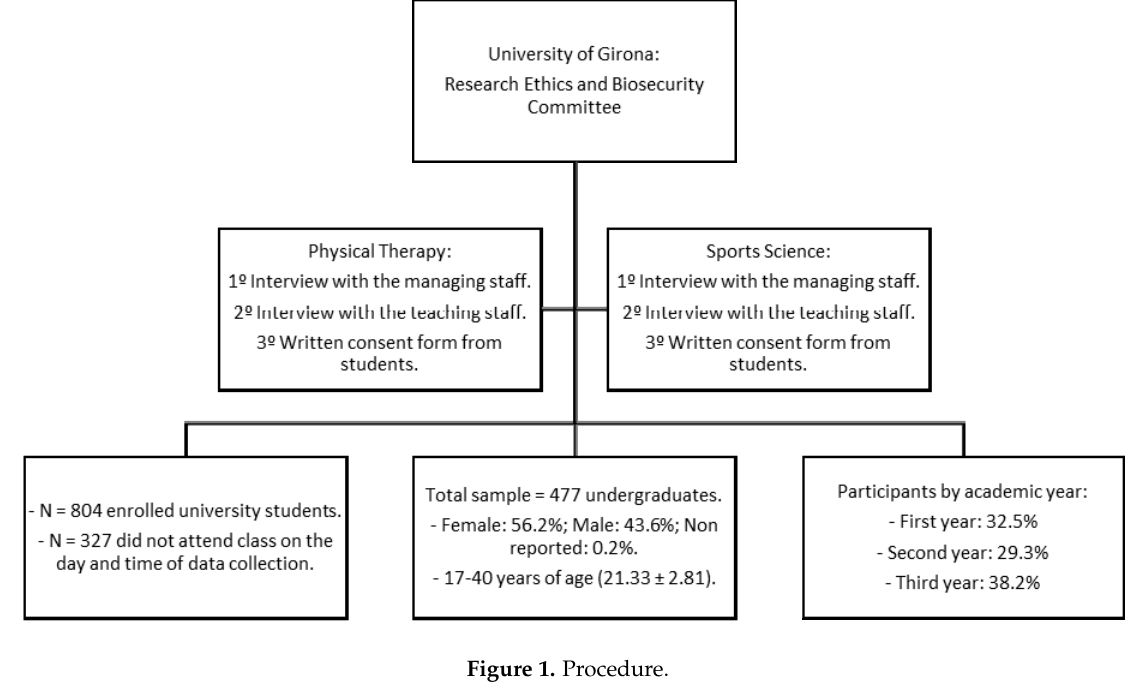
Figure 1. Figure 1. Procedure.